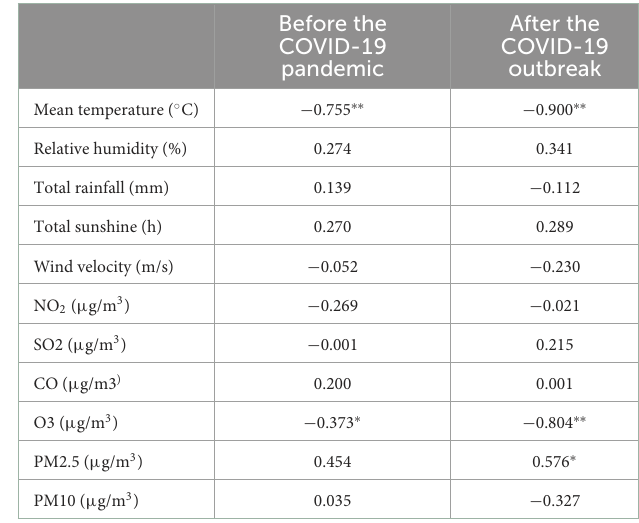
TABLE 5 Partial correlation analysis of meteorological and environmental factors with the incidence of bronchial asthma before and after the COVID-19